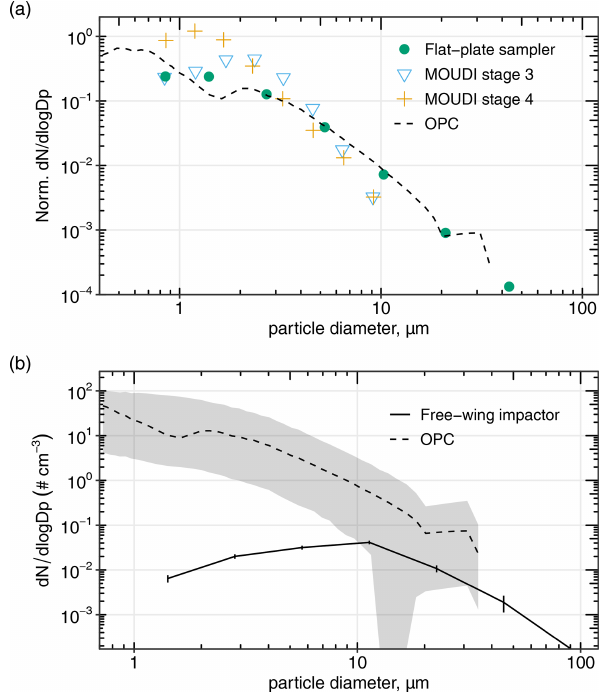
Figure 3. (a) Normalized particle size distribution obtained by dif- ferent sampling techniques averaged over the entire campaign pe- riod. (b) Comparison of the atmospheric particle size distribution between FWI and OPC. The bold line is for FWI, with the error bar showing the Poisson counting error, the dashed line indicates the field campaign mean size distribution from OPC, and the shaded region shows the 95th and 5th percentiles. Note that the collection efficiency of the FWI drops significantly below ∼ 15µm